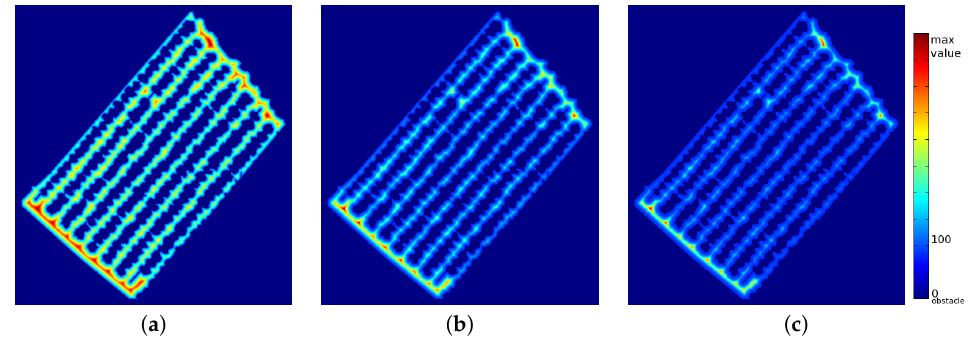
Figure 11. Generating Speed images: ( a – c ) graphical representations of Speed values calculated with Equation (4) for α equal to 1, 2, and